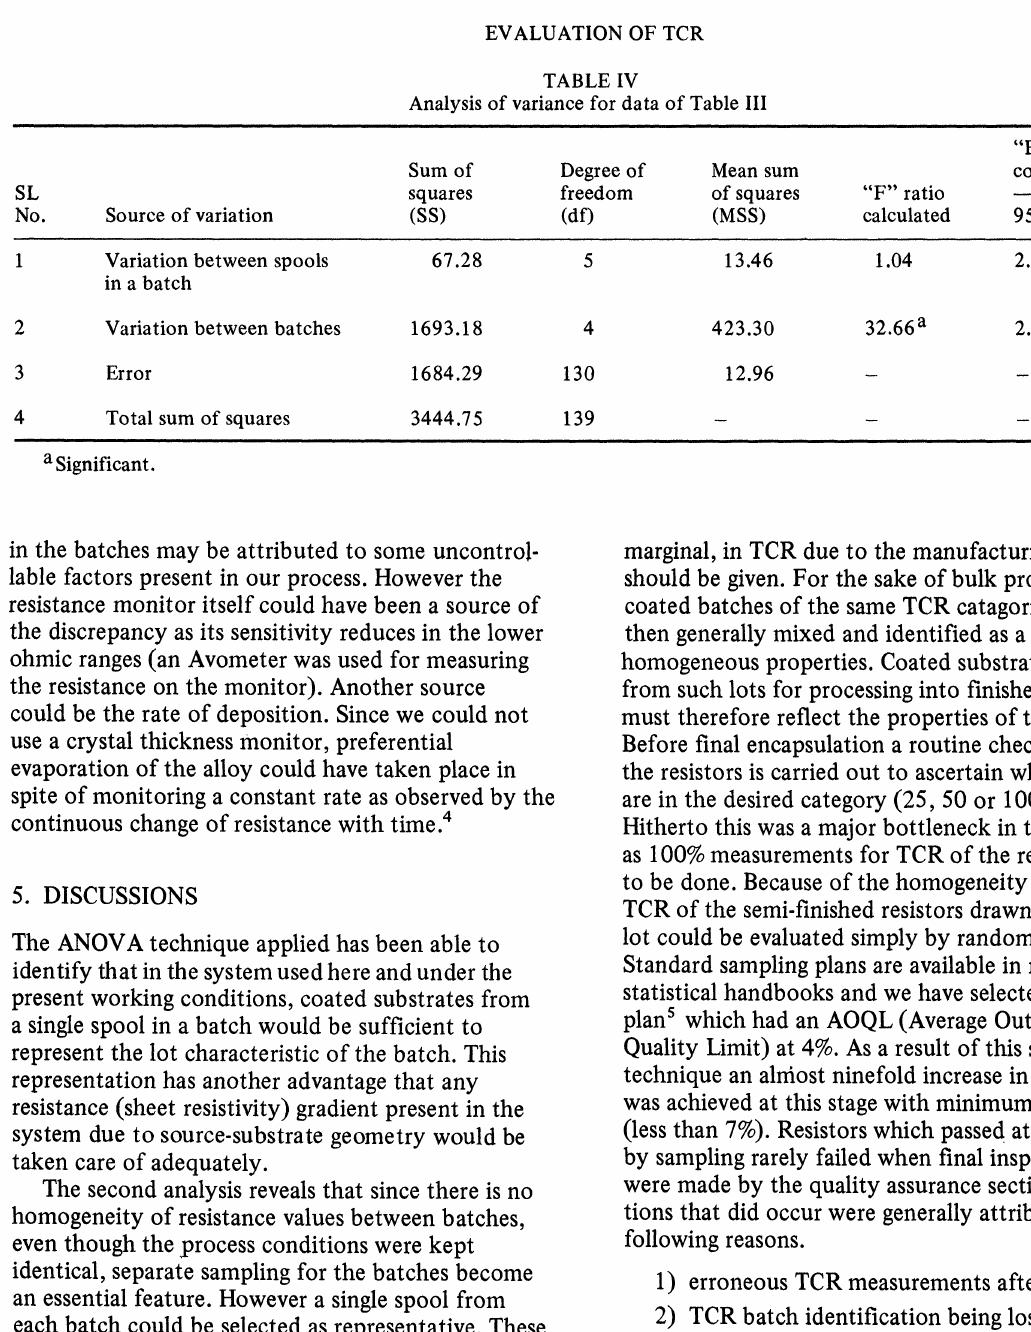
TABLE IV Analysis of variance for data of Table